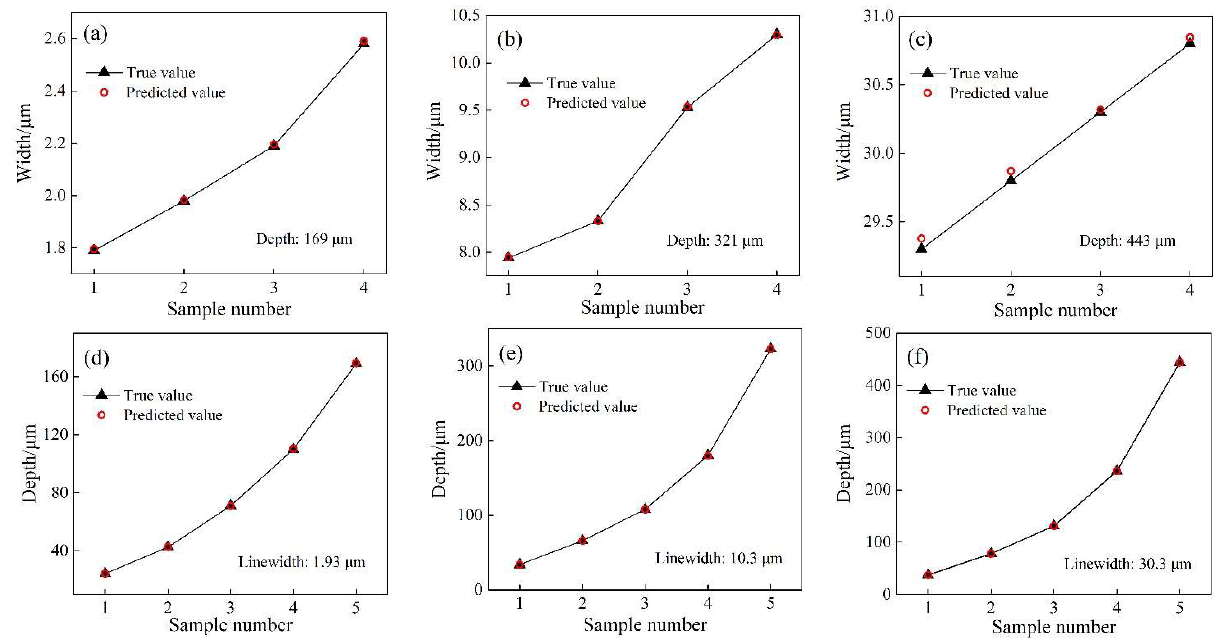
Figure 7. Width and depth prediction results. Comparison between the actual (black triangles) and predicted (red circles) widths of HAR trenches with widths of around ( a ) 2 μm, ( b ) 10 μm, and ( c ) 30 μm; comparison between the actual (black triangles) and predicted (red circles) depths of HAR trenches with widths of ( d ) 1.93 μm, ( e ) 10.3 μm, and ( f ) 30.3 μm.